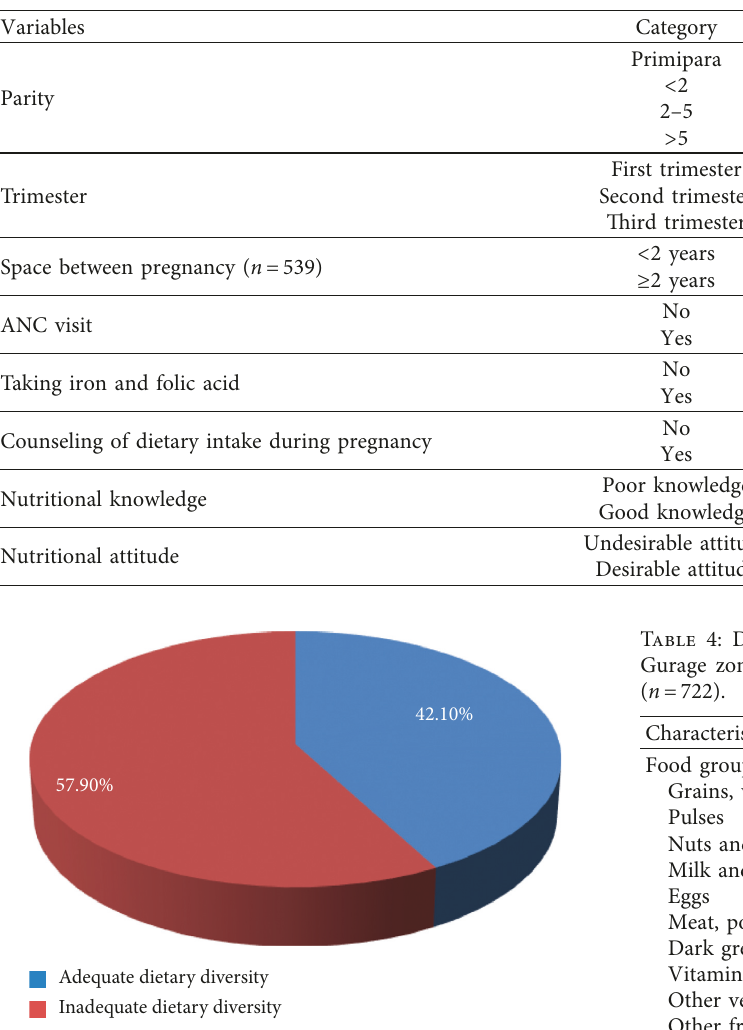
Figure 1: Dietary diversity practice among pregnant women over the last 24 hours in Gurage zone southern Ethiopia 2021 ( n �